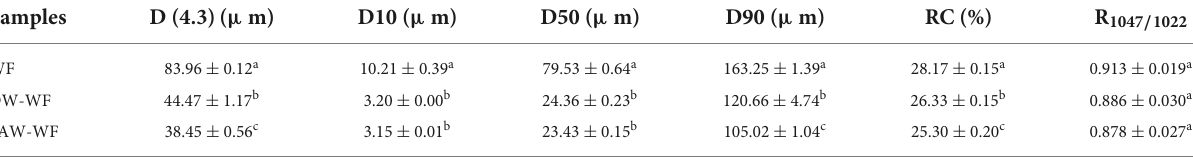
TABLE 2 Particle size, RC, short-range ordered structure of starch in WF, and modified WF. Samples